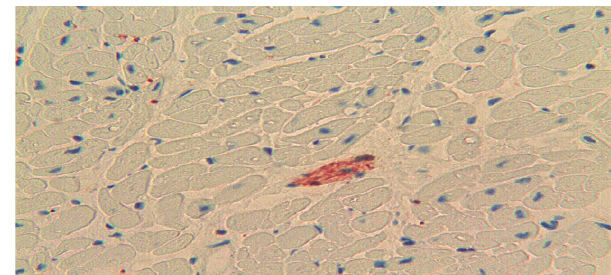
Figure 2 - Diffuse S100B intermyocite positivity with some positivity in perivessels spaces (arrow).